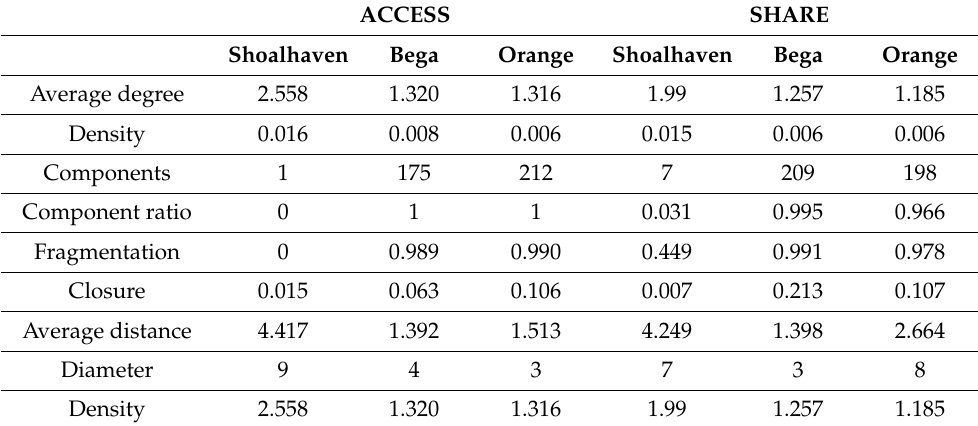
Figure 2. Access and share networks from three case studies: ( a ) Shoalhaven access, ( b ) Shoalhaven share, ( c ) Bega access, ( d ) Bega share, ( e ) Orange access and ( f ) Orange share. Symbol type denotes gender where appropriate (circle = female, square = male, triangle = not applicable). Symbol size denotes in-degree or the number of times that a node was mentioned by other participants. Symbol colour denotes type of organisation: international (red), local government (green), state government (yellow), federal government (orange), mass media (light purple), mass communication (dark blue), social media (pink), research centre (black), individual (khaki) and other (burgundy). Table 5. UCInet cohesion statistics.